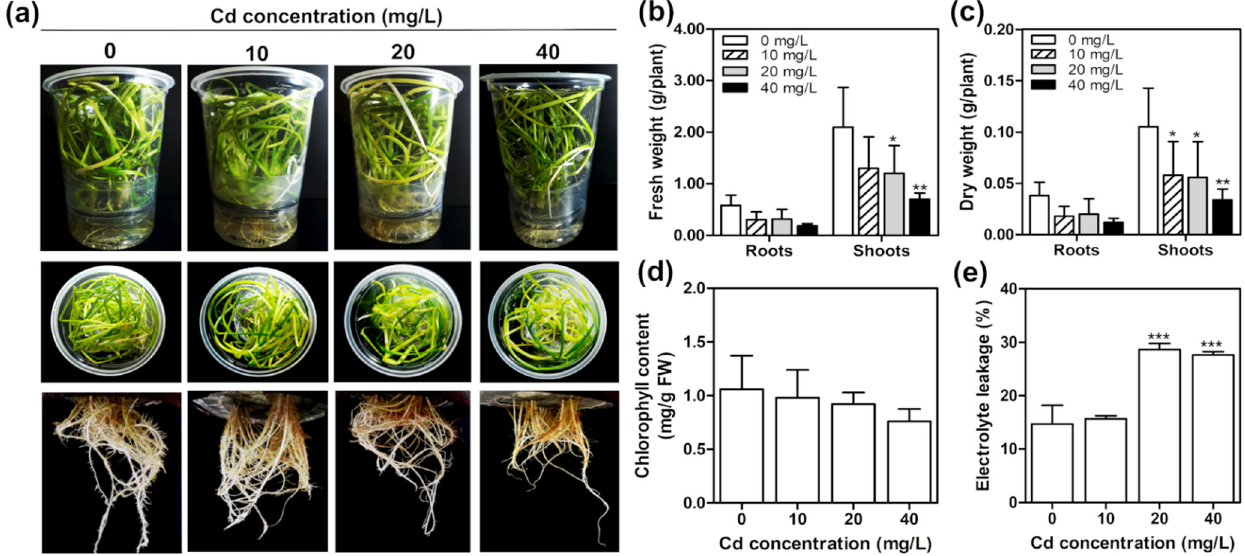
Figure 2. Cd effect on T. latifolia growth. Sixty-day-old T. latifolia plants were exposed to 10, 20, and 40 mg/L of Cd for ten days. ( a ) Shoot and root phenotype appearance, ( b ) fresh weight, ( c ) dry weight, ( d ) leaf chlorophyll content, ( e ) root electrolyte leakage of Cd exposed plants. The values represent the mean ± SD ( n = 3). Asterisks indicate significant differences between control (0 mg/L) and treatment (Dunnett’s test; * p < 0.05, ** p < 0.01 and *** p < 0.001).